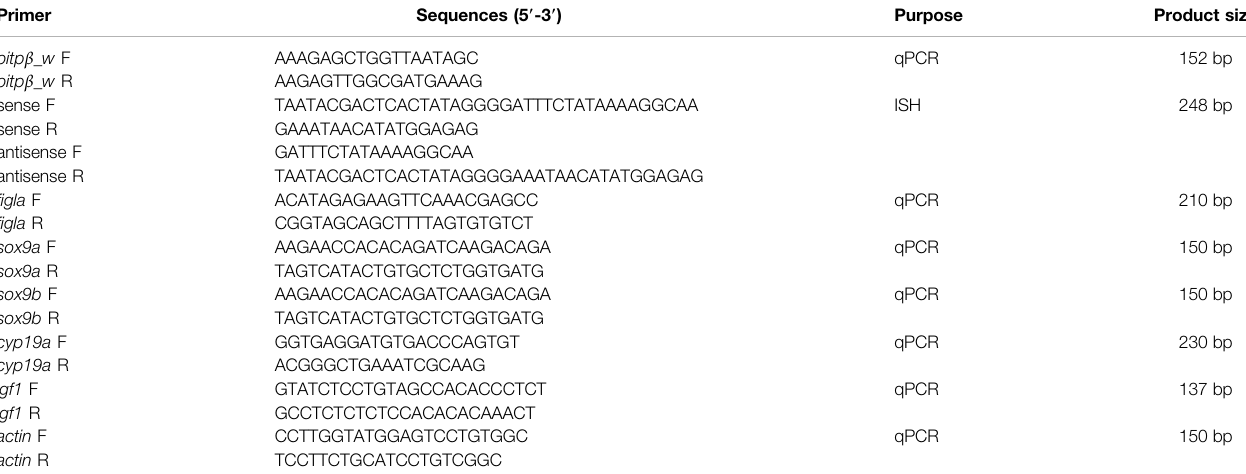
TABLE 1 | Primers used in the study.